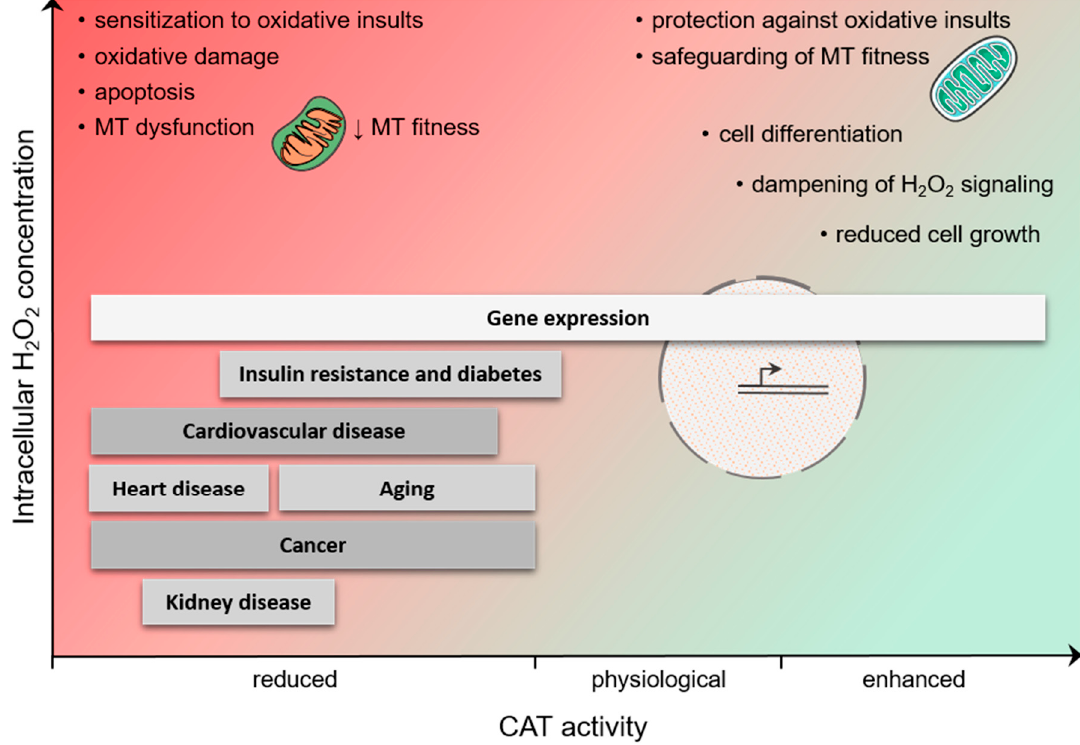
Figure 3. Schematic presentation of how alterations in catalase (CAT) activity may shape intracellular H 2 O 2 gradients, thereby impacting multiple biological processes and contributing to disease initiation and progression. MT, mitochondria.